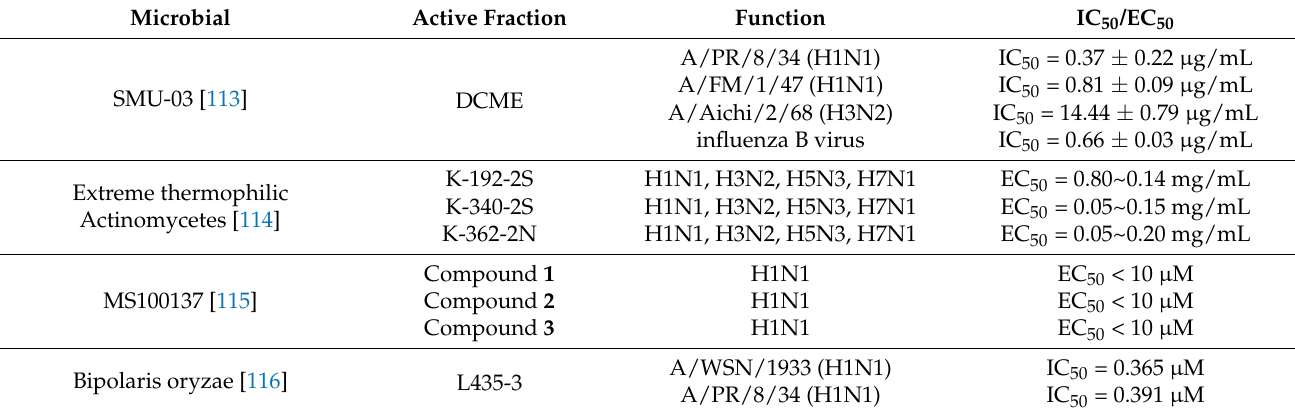
Table 4. List of microbial